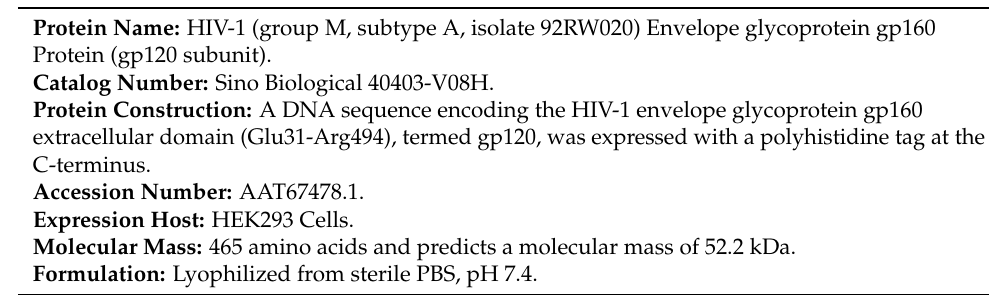
Table 1. Characteristics of recombinant proteins used in this study.